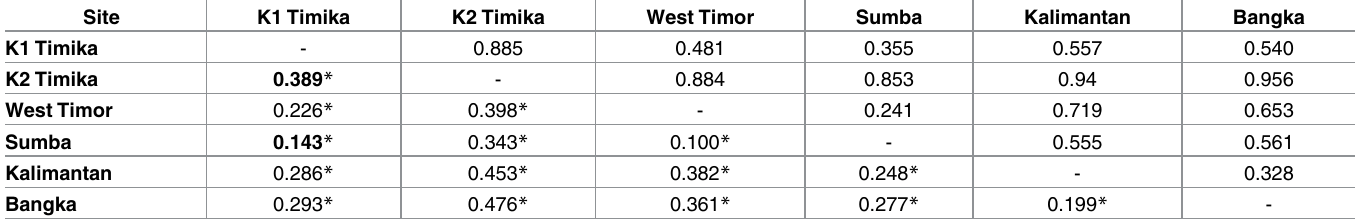
Table 5. Pair-wise differentiation between